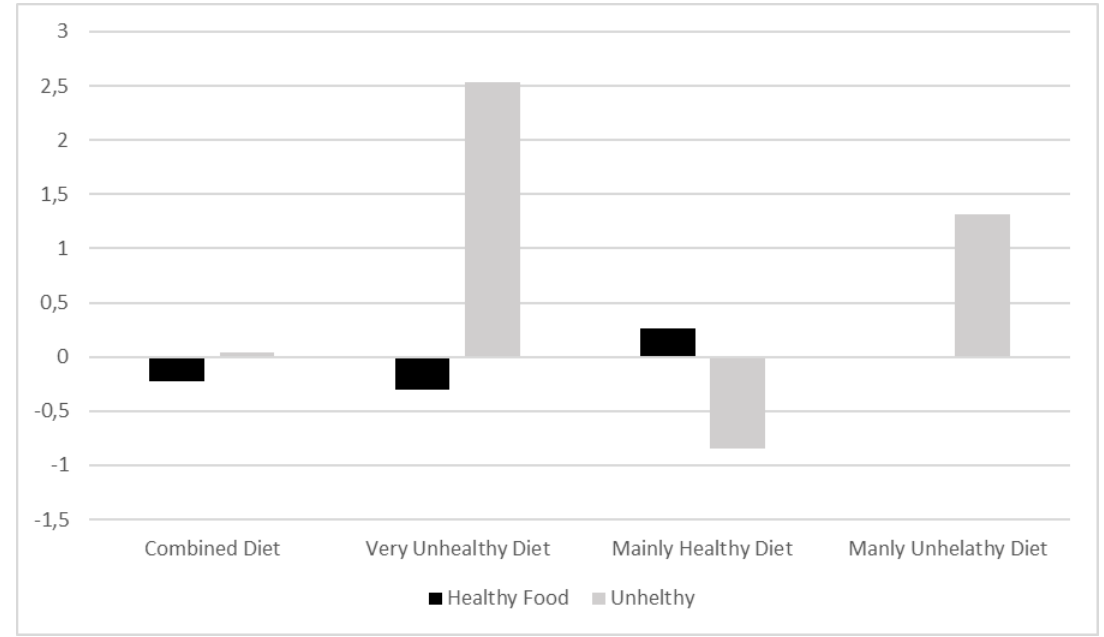
Figure 1. Graphical representation of diet profiles: Combined diet ( n = 303; 45.22%), Very unhealthy diet ( n = 36; 5.37%), Mainly healthy diet ( n = 232; 34.62%), Mainly unhealthy diet ( n = 99; 14.77%).